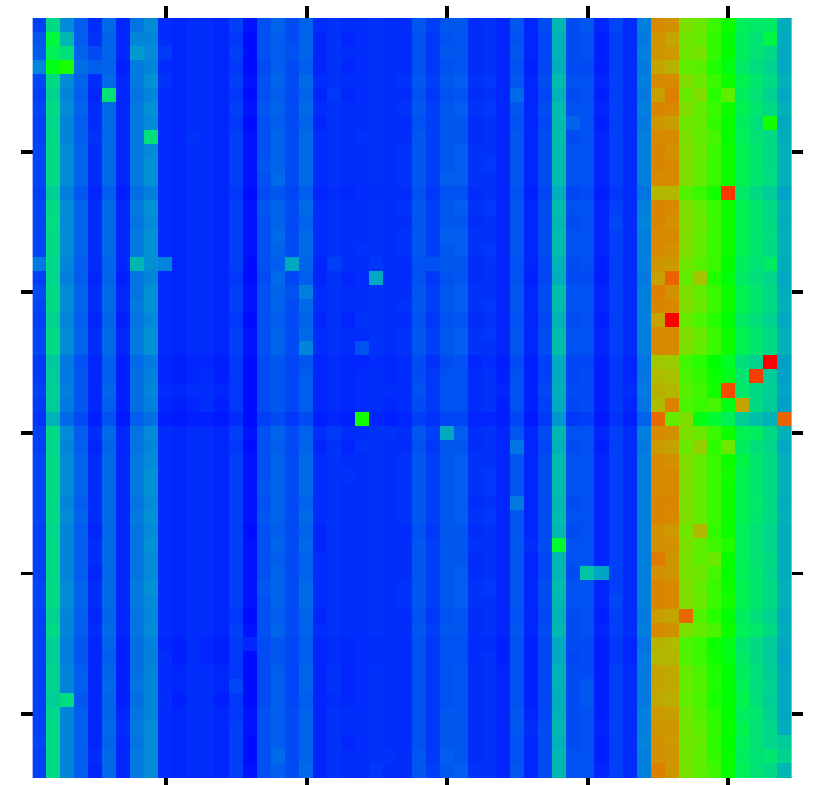
Figure 5. Color density plot of the sensitivity matrix D ab of fibrosis proteins of Table 1; the axes and colors are defined as in Figure 2 (without saturation); the strongest top 40 sensitivity values are given in Table 2.